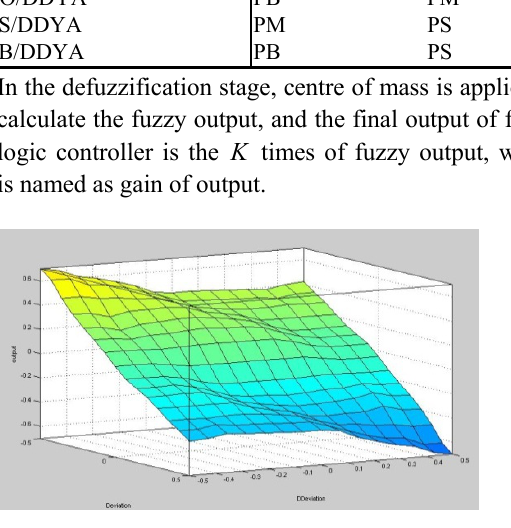
Fig. 14 Surface of inference